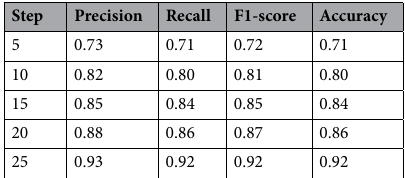
Table 2. The evaluation results of CNN model wall mazed thickness L 1 = L 2 = 200 cm.